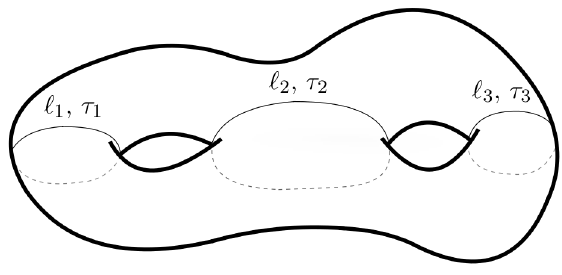
Figure 2 . Fenchel-Nielsen coordinates for a genus-2